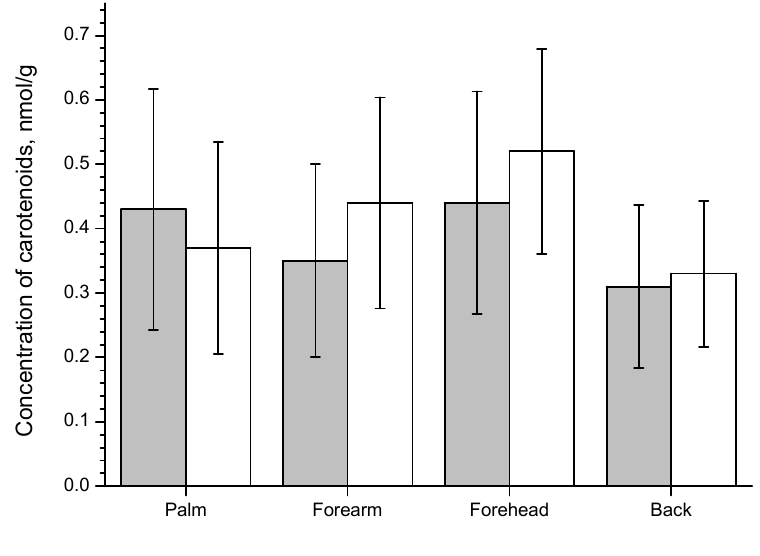
Figure 2. Concentration of β -carotene (grey column) and lycopene (white column) on different body sites measured with resonance Raman